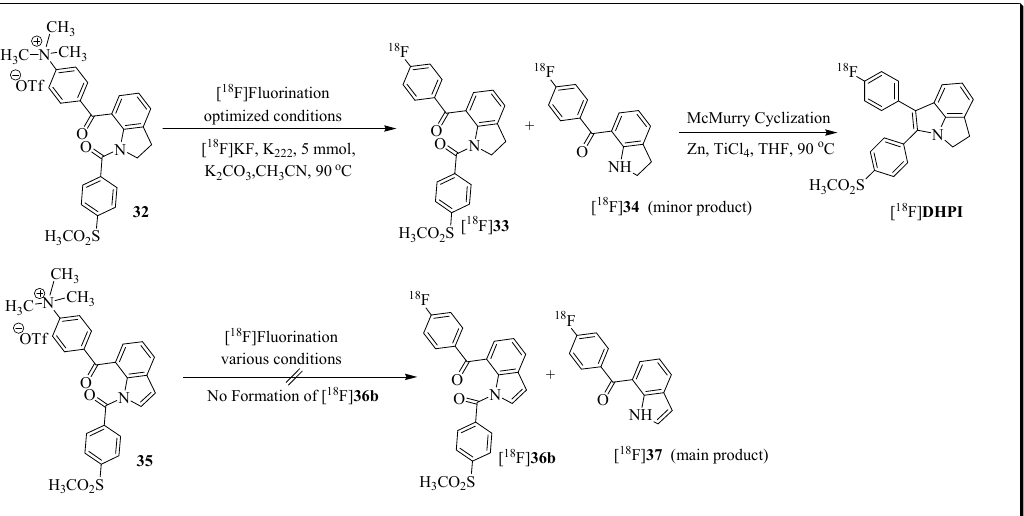
Figure 11. Radiosynthesis route leading to [ 18 F]DHPI . [ 18 F]Fluorination of indoline precursor 32 un- der optimized conditions forms intermediate [ 18 F] 33 , which is subsequently cyclized to [ 18 F]DHPI by McMurry reaction. The [ 18 F]fluorination of indole precursor 35 furnished only side product [ 18 F] 37 instead of [ 18 F] 36, so the McMurry reaction was not feasible.